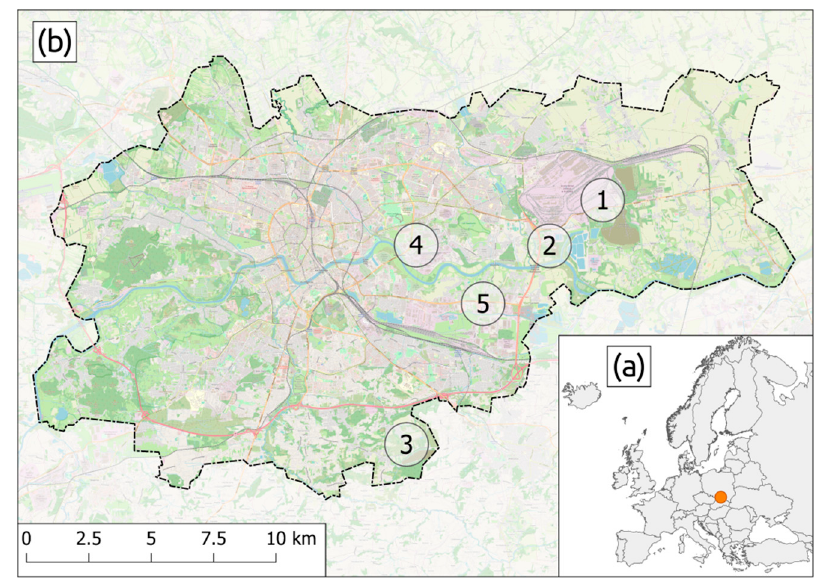
Figure 5. Siting of research facilities: ( a ) At the background of Europe, ( b ) in the city of Krakow,